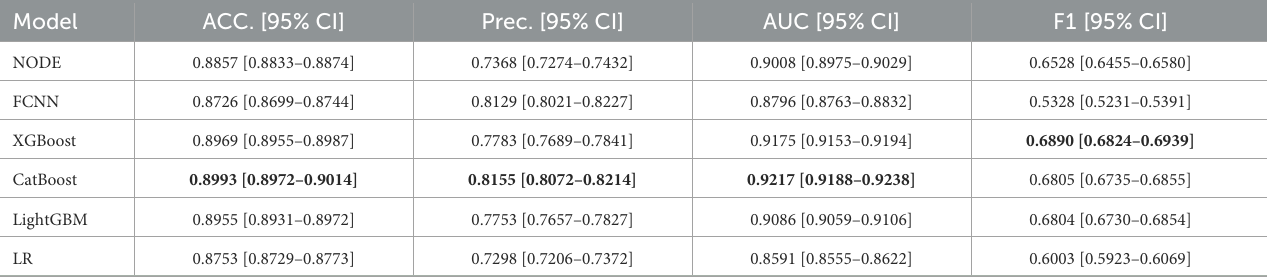
TABLE 2 Predictive performance of each model.